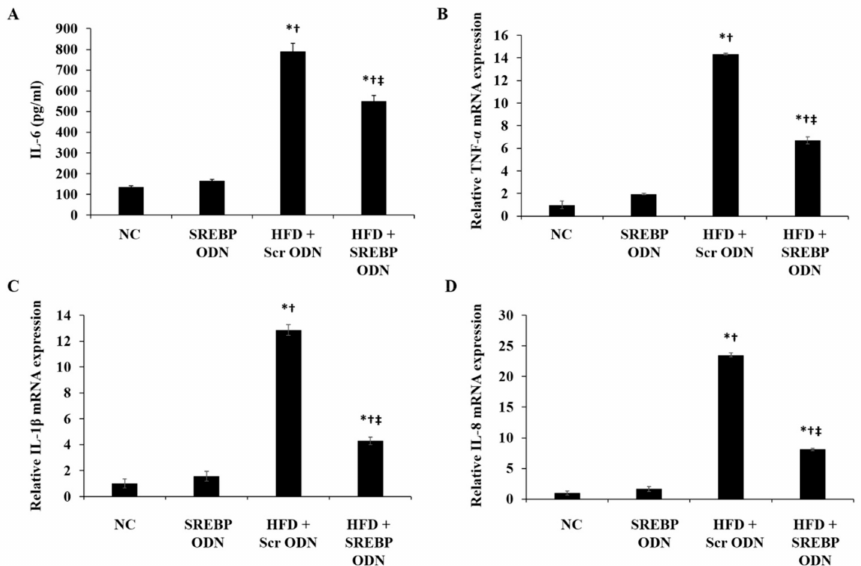
Figure 3. SREBP decoy ODN significantly inhibits the pro-inflammatory cytokines in the HFD-induced hyperlipidemic mouse model ( n = 6). ( A ) ELISA results demonstrate that SREBP decoy ODN inhibits the IL-6 expression in hyperlipidemic mice. ( B – D ) Real-time PCR results show that SREBP decoy ODN inhibits expressions of TNF- α , IL-1 β , and IL-8. NC, normal control group; SREBP ODN, group treated with SREBP decoy ODN; HFD + Scr ODN, HFD fed group treated with scrambled decoy ODN; HFD + SREBP ODN, HFD fed group treated with SREBP decoy ODN. * p < 0.05 compared to the NC group. † p < 0.05 compared to the SREBP ODN group. ‡ p < 0.05 compared to the HFD + Scr ODN